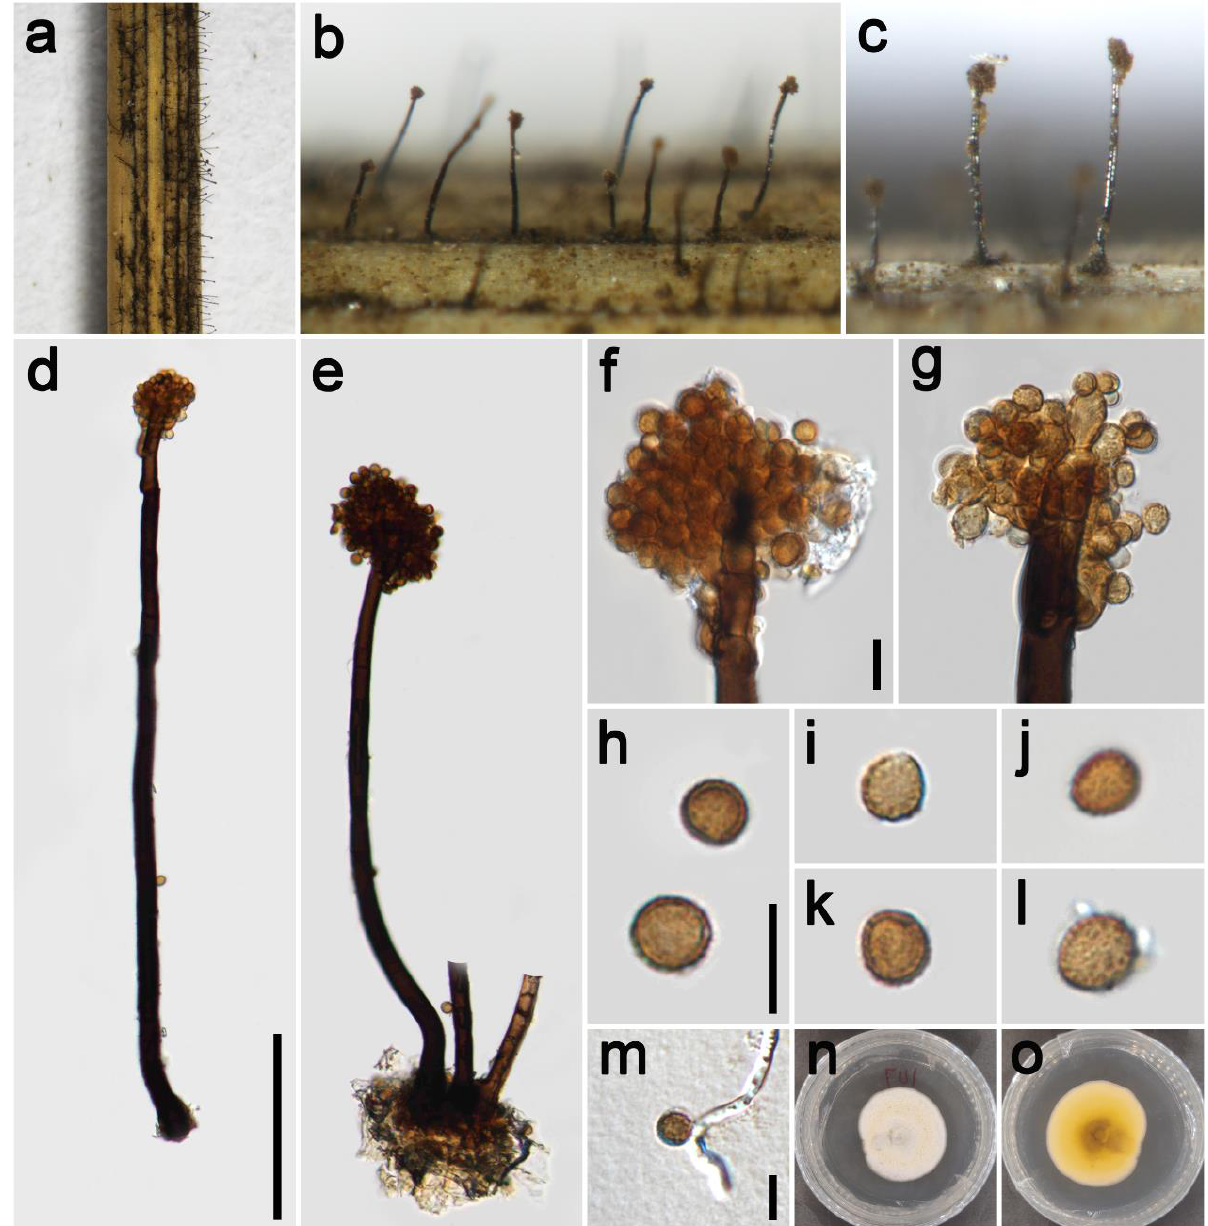
Figure 7. Periconia festucae (HKAS 126516, holotype). ( a – c ) Colonies on the natural substrate; ( d , e ) conidiophores with spherical conidial heads; ( f , g ) apical branch conidiophores with conidial head; ( h – l ) conidia; ( m ) germinating conidium; ( n , o ) colony on PDA from above and below. Scale bars: ( d ) = 100 µ m, ( f , h , m ) = 10 µ m. Scale bar of ( d ) applies to ( e ). Scale bar of ( f ) applies to ( g ). Scale bar of ( h ) applies to ( i – l